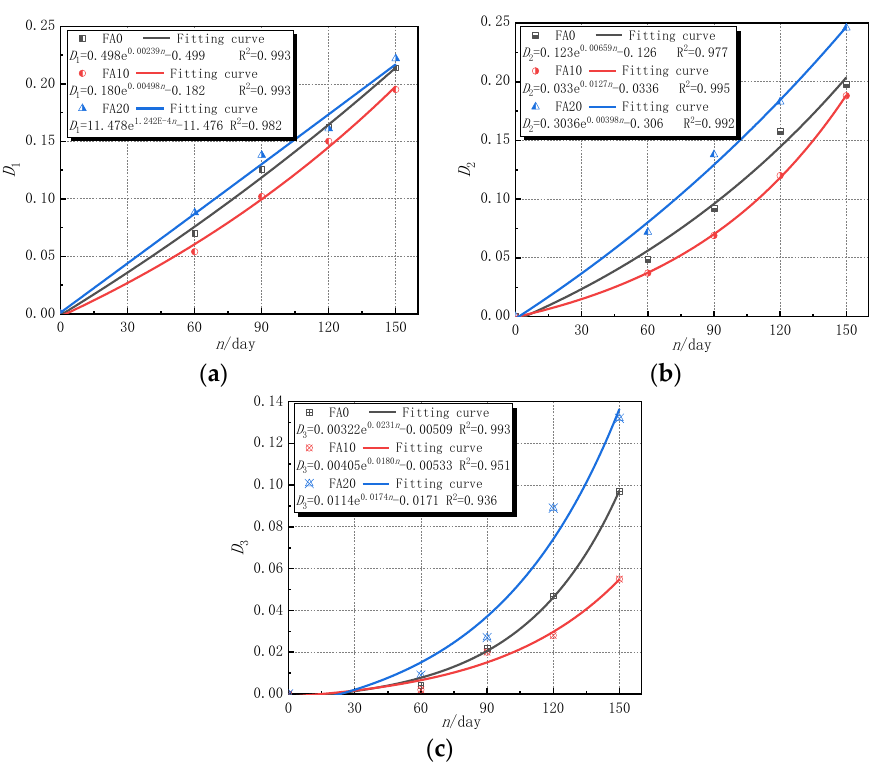
Figure 8. Relationship between damage variable of different evaluation indexes and erosion times.